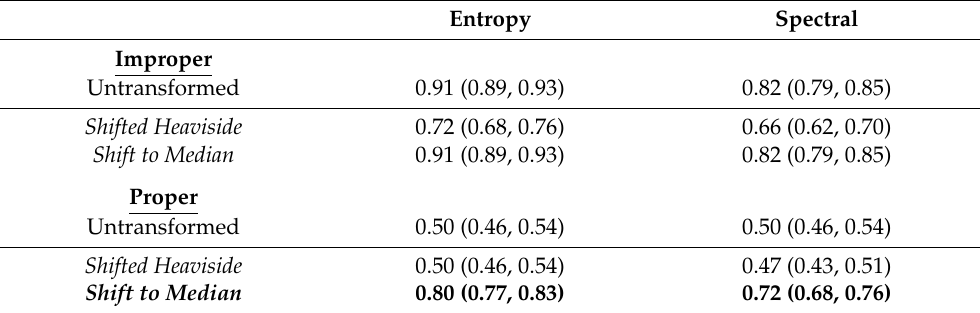
Table 1. Classification accuracies for the 12 models generated from transformed and non-transformed driver fatigue data. Improper models were generated with the improper method of cross-participant model generation utilizing 12-fold CV with all participant data shuffled together and split across 12 folds, and proper model generation utilized 12-fold LOPO CV. The purpose of this table is two-fold. One is to depict that improper model generation typically results in overestimated model accuracy as can be seen with increased accuracies for improper vs. proper. The other is to depict the results of the proper method on untransformed data versus the proper method on the two transformed datasets. Bold signifies dominance in accuracy of the 95% confidence interval from the transformation in comparison of the 95% confidence